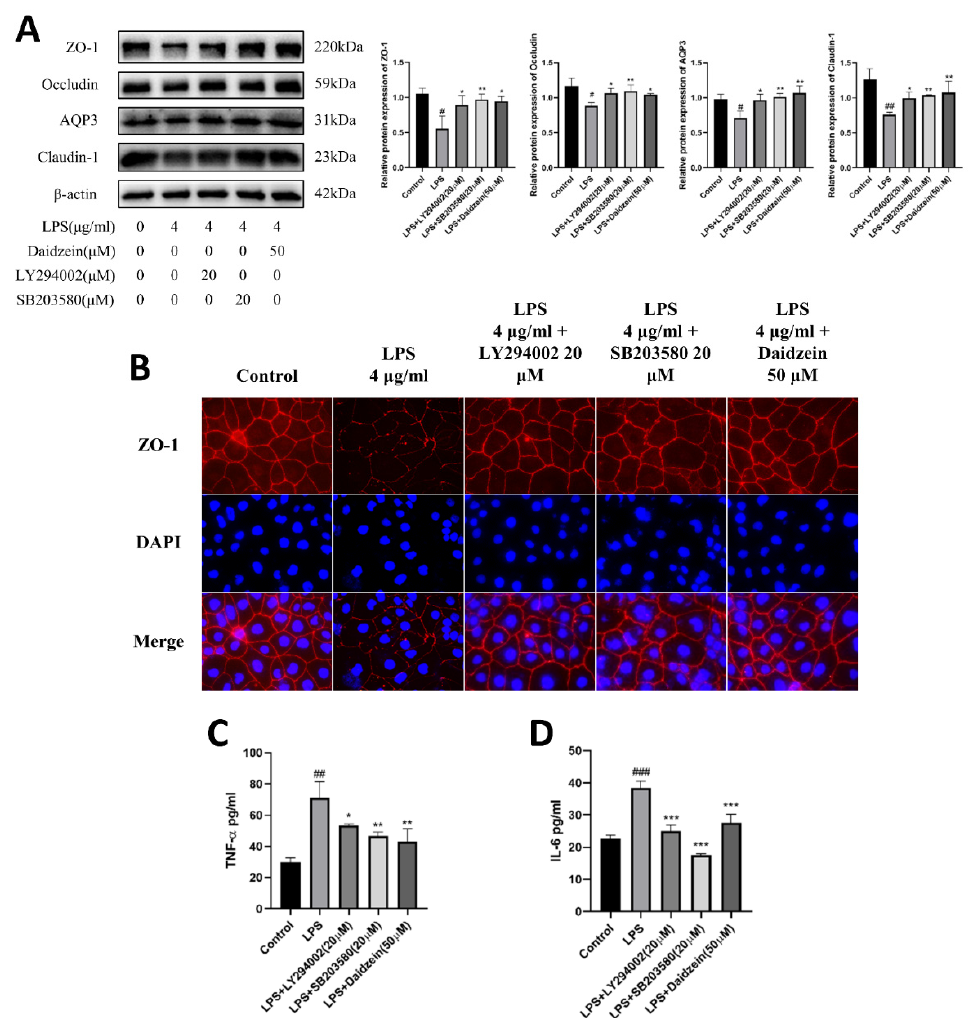
Figure 7. Daidzein improved the LPS-induced downregulation expression of tight junctions and AQP3 proteins and inflammation by inhibiting the PI3K/AKT and P38 pathways. ( A ) The protein expression levels of ZO-1, occludin, claudin-1, and AQP3 and protein quantitative analysis. ( B ) The tight junction of the ZO-1 protein. The red signal indicates ZO-1, and the blue one indicates the nuclei. ( C ) The level of TNF- α . ( D ) The level of IL-6 (mean ± SD, n = 3), * p < 0.05, ** p < 0.01, and *** p < 0.001 versus LPS-treated alone. # p < 0.05, ## p < 0.01, and ### p < 0.001 versus control.